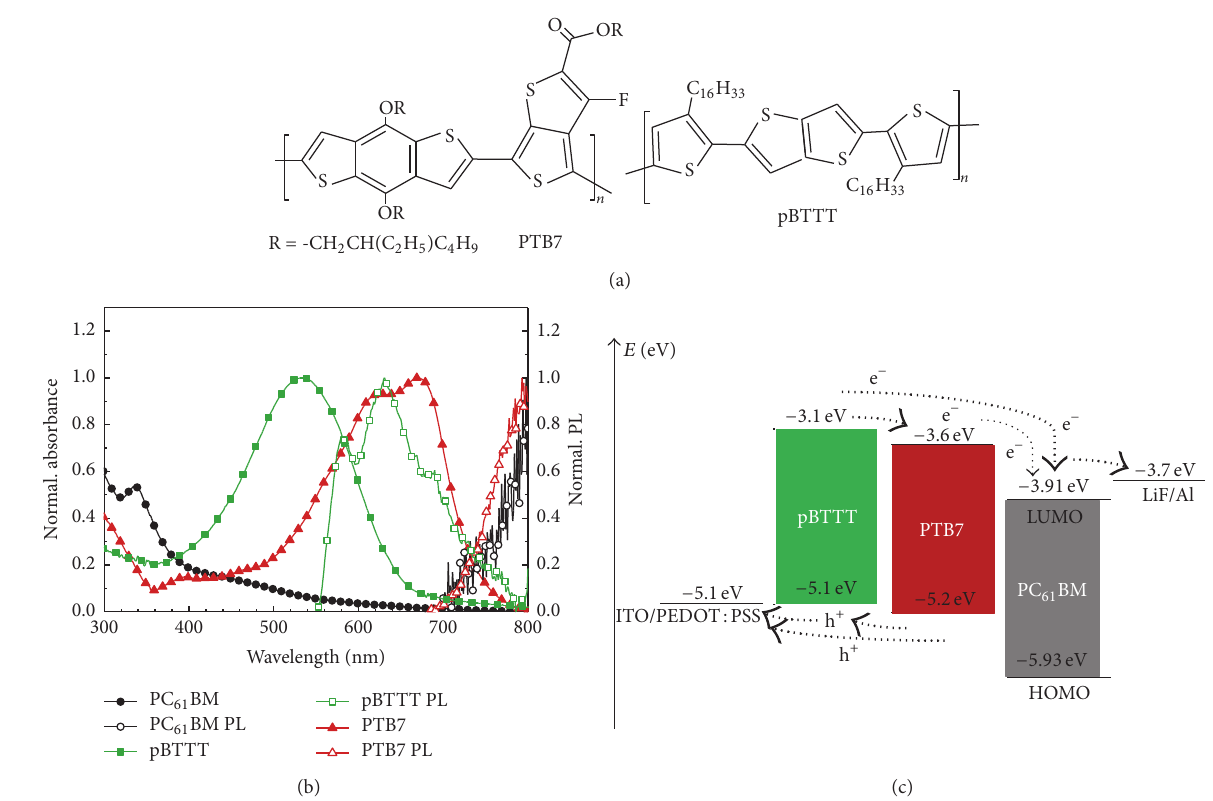
Figure 1: (a) Chemical structures of the two polymers, PTB7 and pBTTT. (b) Normalized UV-Visible absorption spectra (filled symbols) of films of PC 61 BM, pBTTT, and PTB7 and corresponding PL spectra (open symbols) recorded upon excitation at 330 nm (PC 61 BM), 535 nm (pBTTT), and 675 nm (PTB7) and (c) energy diagram of the ternary blend